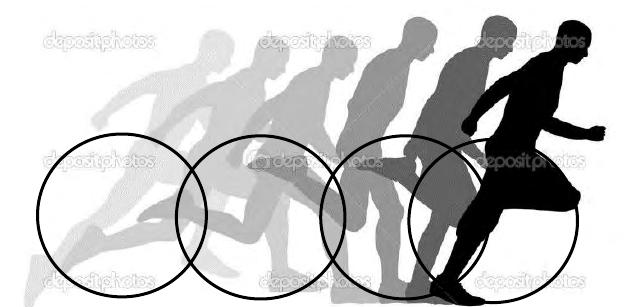
Fig.1. Illustration of “principle of wheel” in technique of run